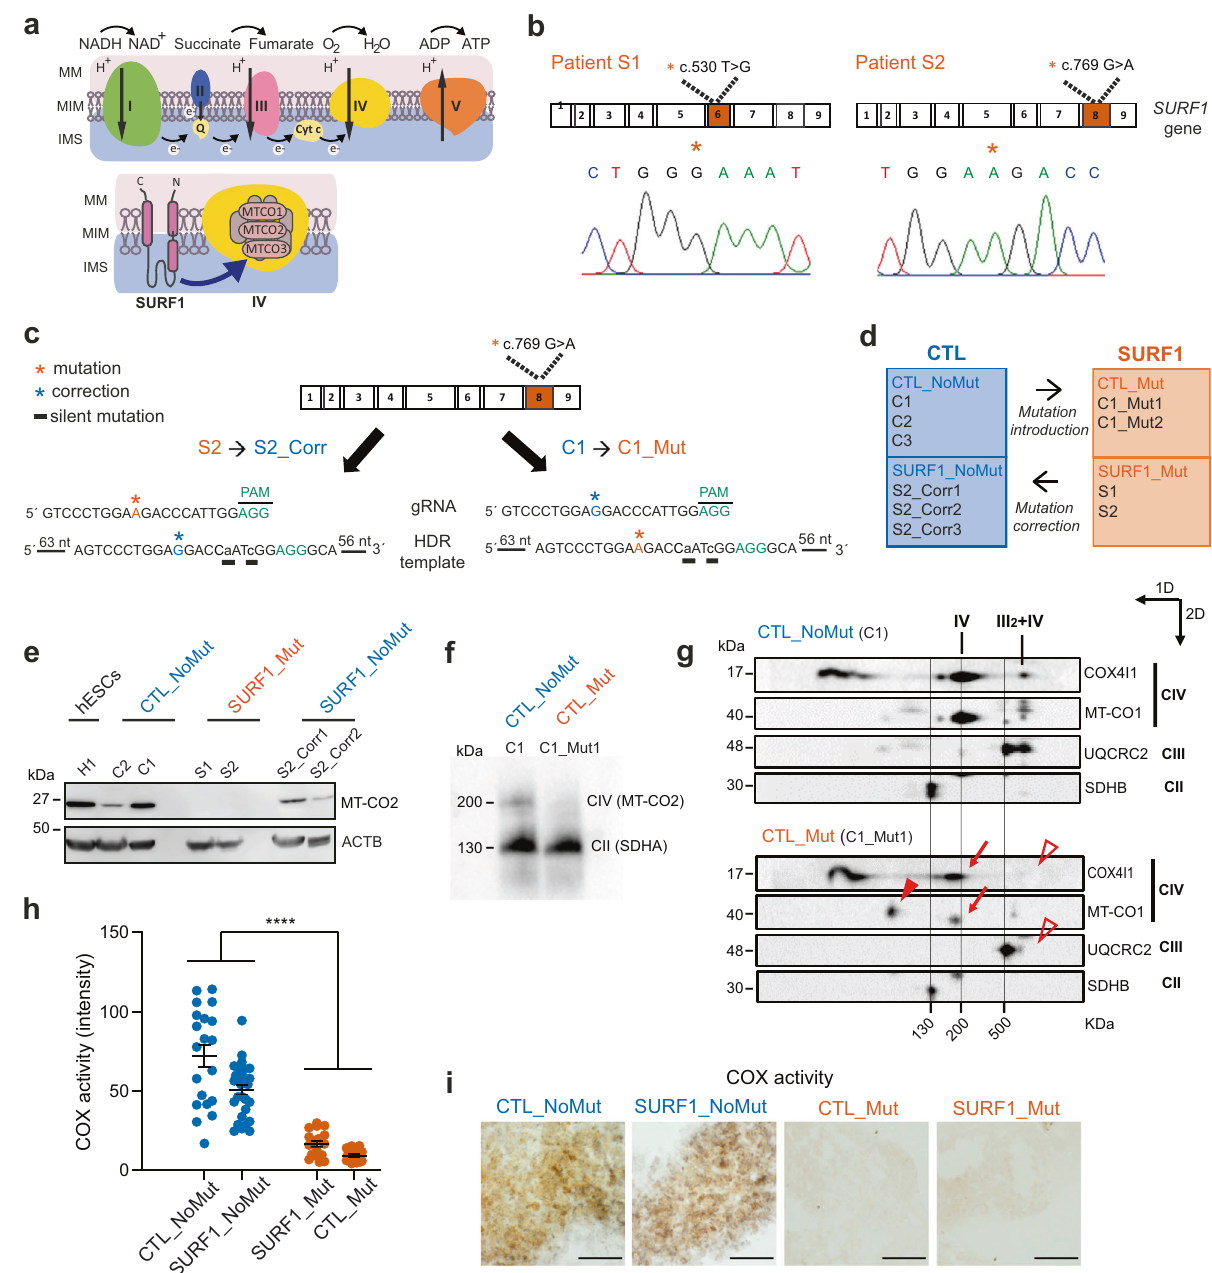
Fig. 1 Generation of an iPSC-based model of LS due to SURF1 mutations. a Mitochondrial respiratory chain and putative SURF1 function in CIV assembly. MM mitochondrial membrane, IMM inner mitochondrial membrane, IMS intermembrane space. b Electropherograms showing 5 ′ > 3 ′ sequences of SURF1 in iPSCs from patients S1 and S2 carrying the mutations c.530T > G p.(V177G) and c.769G > A p.(G257R), respectively. Orange stars: mutation site. c Genome editing approach to correct mutation c.769G > A in patient line S2, and to introduce the same mutation in control line C1. Orange stars: mutation site; blue stars: correction site; black underlines: arti fi cially introduced silent mutations; gRNA: guide RNA; HDR: homology direct repair. d Overview of iPSC lines used in this study. e Immunoblot of MT-CO2 (26 kDa) in NPCs derived from hESCs (H1), CTL (CTL_NoMut: C2, C1; SURF1_NoMut: S2_Corr1, S2_Corr2), and SURF1 (SURF1_Mut: S1, S2) ( n = 2 independent experiments). f One dimensional (1D) blue-native gel electrophoresis (BNGE) analysis of mitochondrial complexes showing lack of incorporation of MT-CO2 into CIV in NPCs from CTL (CTL_NoMut: C1) and SURF1 (CTL_Mut: C1_Mut1). The structure of the complex II (CII) (visualized by SDHA antibody) was not affected ( n = 2 independent experiments). g Two-dimensional (2D) BNGE showing mitochondrial complex assembly in NPCs from CTL (CTL_NoMut: C1) and SURF1 (CTL_Mut: C1_Mut1). Red arrows: structurally impaired CIV migrating at lower molecular weight (detected by MT-CO1 and COX4I1 antibodies); red arrowhead: accumulation of COX assembly intermediates (detected by MT- CO1 antibody); open red arrowheads: loss of III2 + IV supercomplex (detected by COX4I1 and UQCRC2 antibodies). We used CIII (detected by UQCRC2 antibody) and CII (detected by SDHB antibody) to align CTL blot with SURF1 blot ( n = 2 independent experiments). h , i Quanti fi cation and representative images of COX activity intensity in CTL NPCs (CTL_NoMut: C1, C2, C3; SURF1_NoMut: S2_Corr1, S2_Corr2) and SURF1 NPCs (SURF1_Mut: S1, S2; CTL_Mut: C1_Mut1) (mean ± s.e.m.; each dot represents a biological replicate; n = 10 biological replicates per line over three independent experiments; **** p < 0.0001 CTL vs. SURF1; two-sided Mann – Whitney U test). Scale bar: 500 nm. NATURE COMMUNICATIONS| (2021) 12:1929